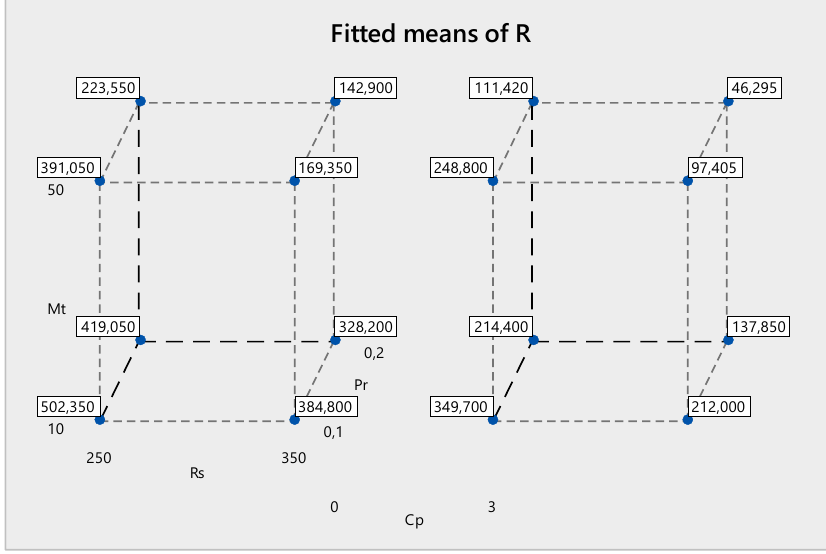
Figure 6. Cube plot for the average particle size in the full factorial design.